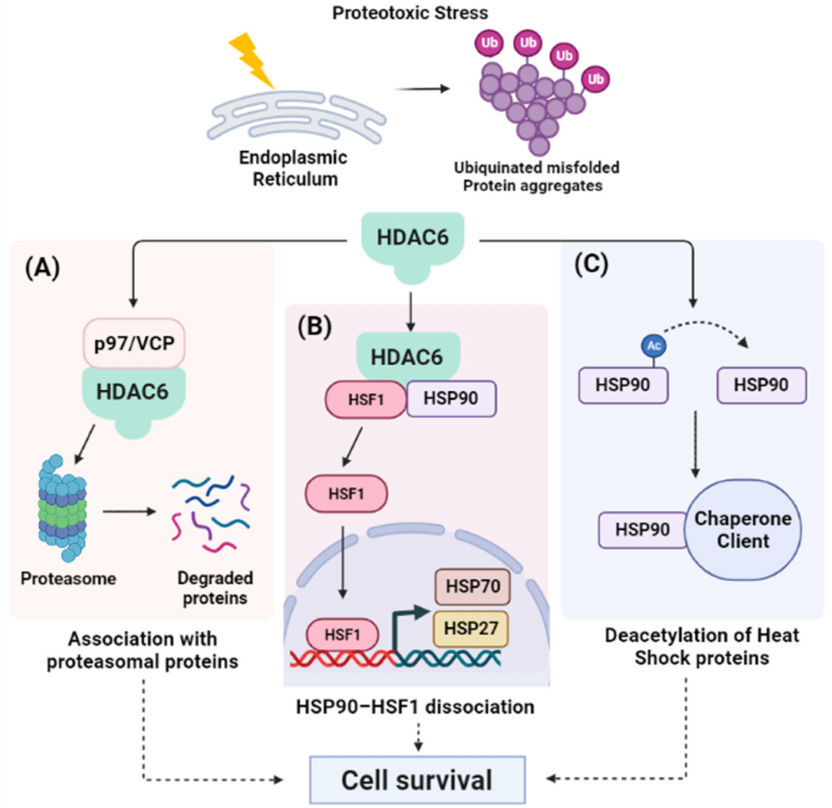
Figure 3. HDAC6 regulates the response to misfolded protein aggregates. Under proteotoxic stress, cancer cells evolve an intricate set of signaling to allow the cell to respond to the presence of misfolded proteins within the endoplasmic reticulum (ER). HDAC6 is considered a master regulator in misfolded protein processing through three different pathways: ( A ) HDAC6 forms a complex through its ZnF- UBP domain with proteasomal proteins such as p97/VCP that binds to polyubiquitinated proteins, facilitating their proteasomal degradation; ( B ) In unstressed cells, HDAC6 usually exists in complex with an inactive HSF1 and HSP90. Upon ER stress, this complex is dissociated and the liberated HSF1 activates the expression of heat shock genes (HSP70 and HSP27). These heat shock proteins are essential components of the cell machinery that are required for the proper folding of proteins and the degradation of damaged proteins to protect against the adverse effects of proteotoxic stress; and ( C ) HDAC6 deacetylates HSP90, enhancing its chaperone activity, and facilitates the recruitment of other chaperones to reduce the level of unfolded proteins. At the end, upgrading the chaperone capacity in processing misfolded proteins by HDAC6 promotes cell survival. Abbreviations: Ub, ubiquitin; VCP, valosin-containing protein; HSF1, heat shock transcription factor 1; HSP90, heat shock protein 90; HSP70, heat shock protein 70; HSP27, heat shock protein